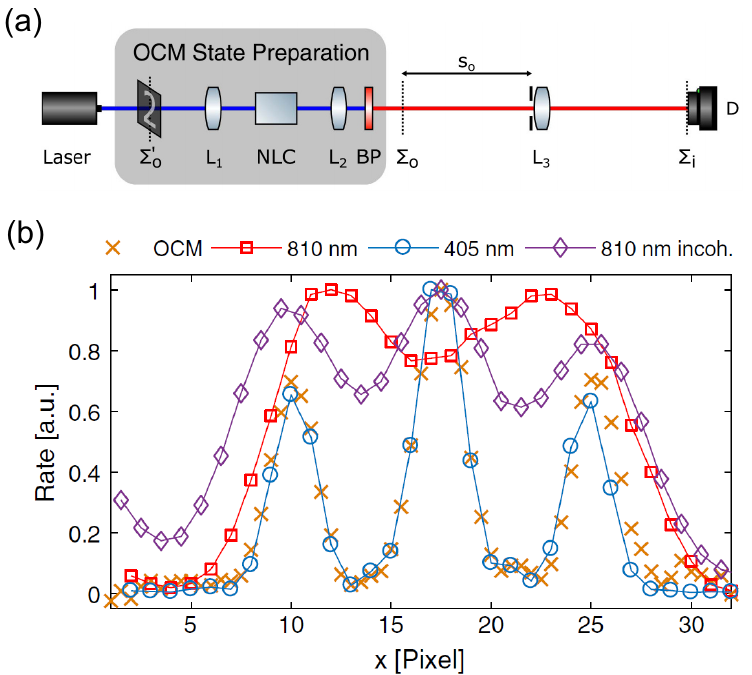
Figure 9. ( a ): Schematic of the super-resolution imaging scheme by encoding the image of an object onto the optical centroid measurement state (OCM). The spatial information of the object is first encoded onto the pump light ( ∑ (cid:48) ), and a lens L 1 is used to project the pump light onto its focal plane, 0 where parametric down conversion process transfers the Fourier information of the object into the two-photon amplitude of the generated entangled light. By employing an additional Fourier transform with lens L 2 , the OCM state of the object is built, i.e., subwavelength far-field interference of the Fourier image of the object. ( b ): HL super-resolution image realized through the OCM state of a triple-slit object with entangled light at 810 nm. The super-resolution effect is demonstrated by comparing with the conventional intensity images at wavelengths 810 nm and 405 nm. The figure is reproduced with permissions from Ref. [41] of